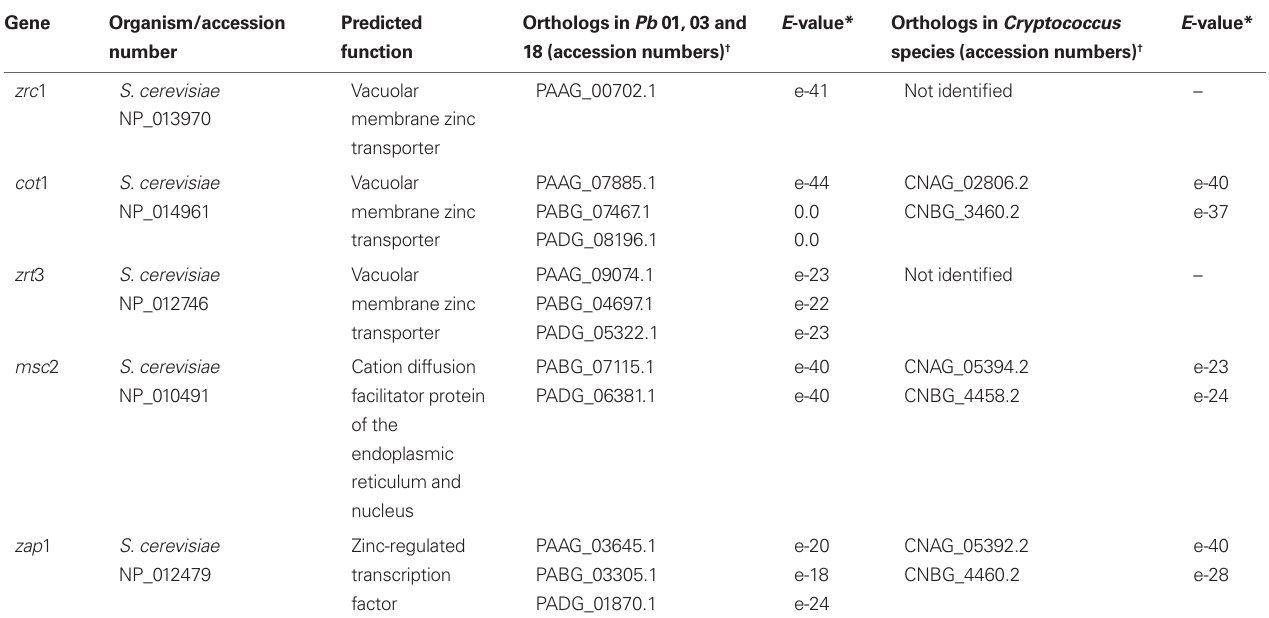
Figure 1 . This biosynthetic pathway may lead to the production of hydroxamate-type siderophores. The first committed step in siderophore biosynthesis is the N 5 -hydroxylation of ornithine cata- lyzed by ornithine-N 5 -oxygenase. The sid1 gene of Ustilago may- dis, the etiologic agent of corn smut, was the first